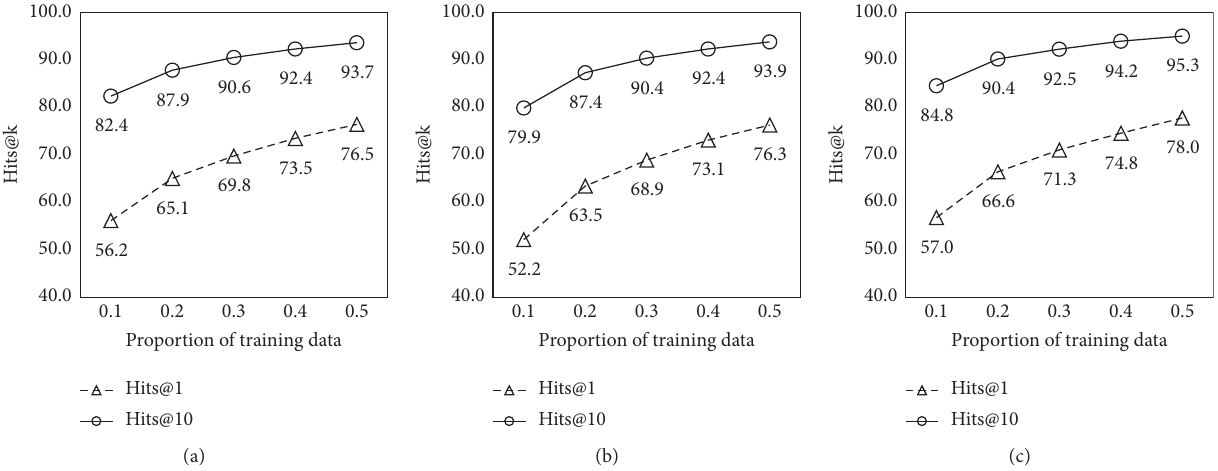
Figure 4: Hits @ k on entity alignment with respect to the proportion of training data. (a) DBP